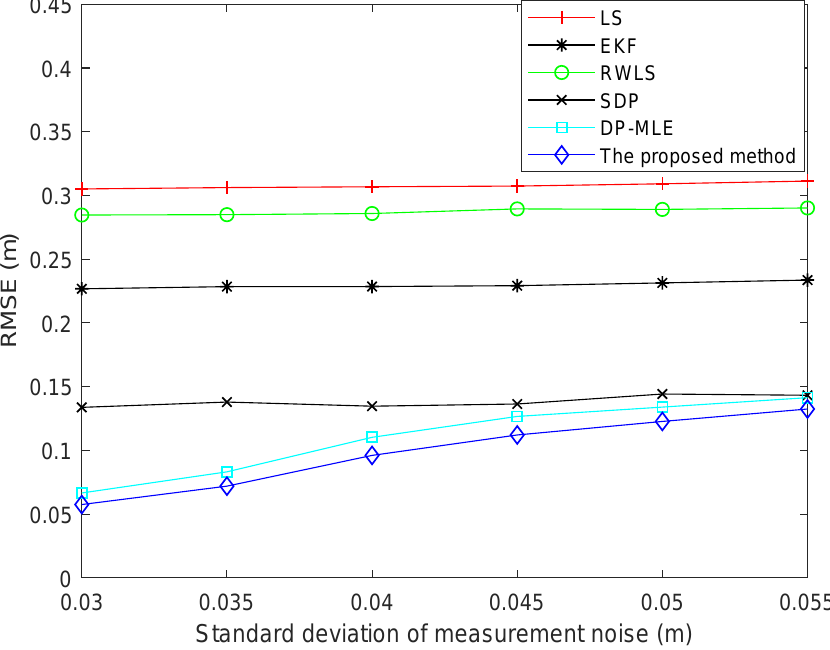
Figure 5. RMSE of different algorithms using different standard deviations of measurement